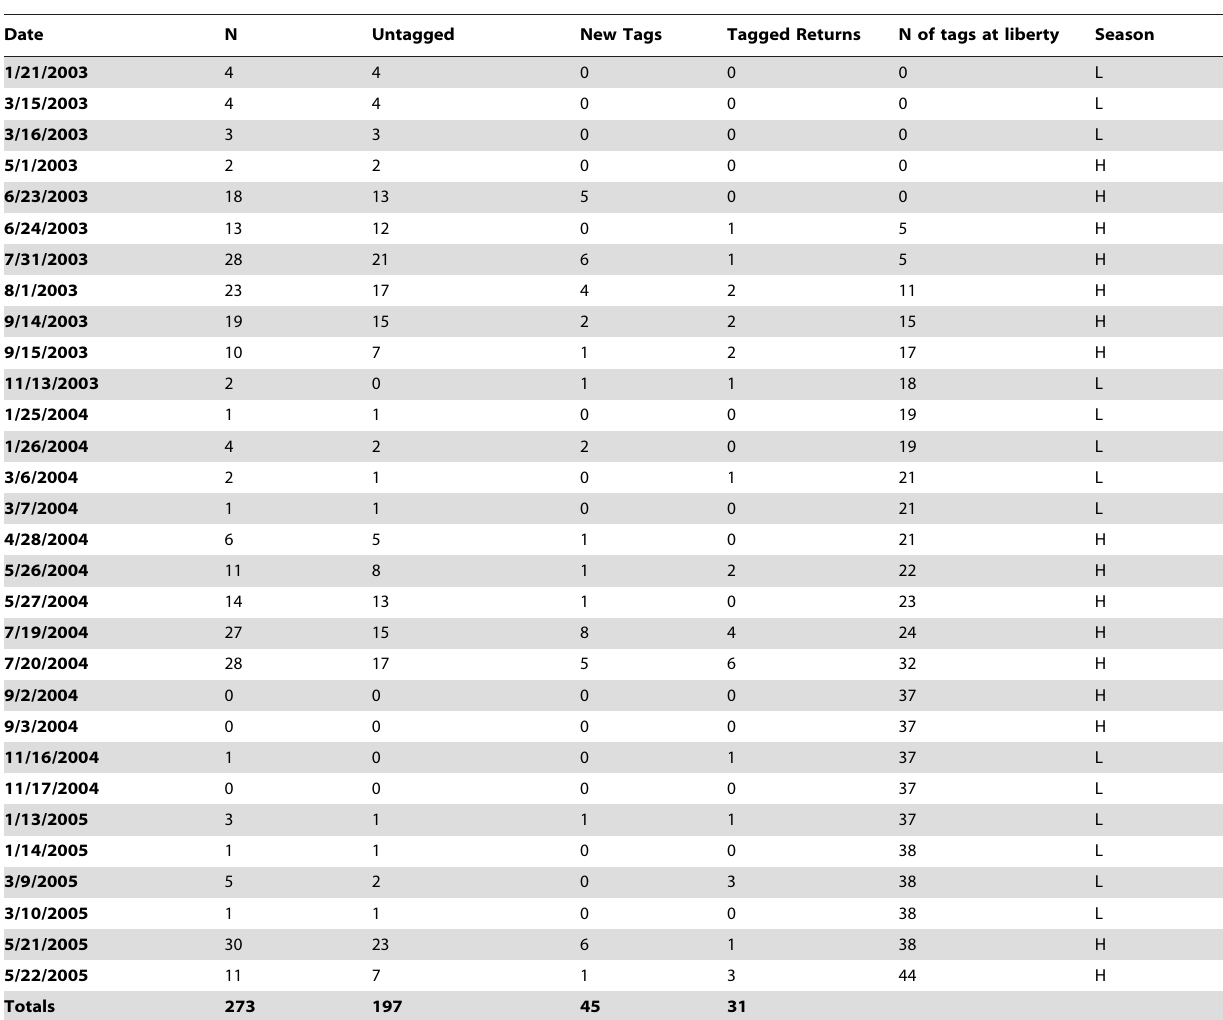
Table 2. Number of sharks observed at Seattle Aquarium by research date.